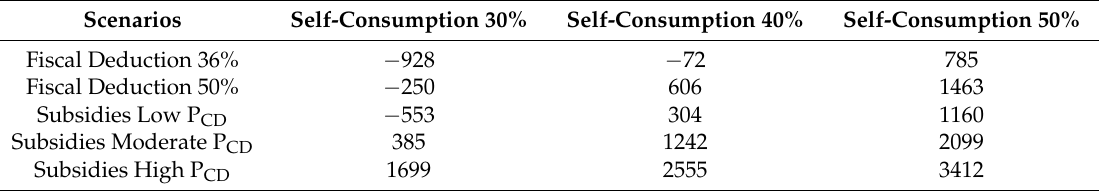
Table 4. NPV in alternative scenario (p c = 17 cent € /kWh). Data expressed in € .